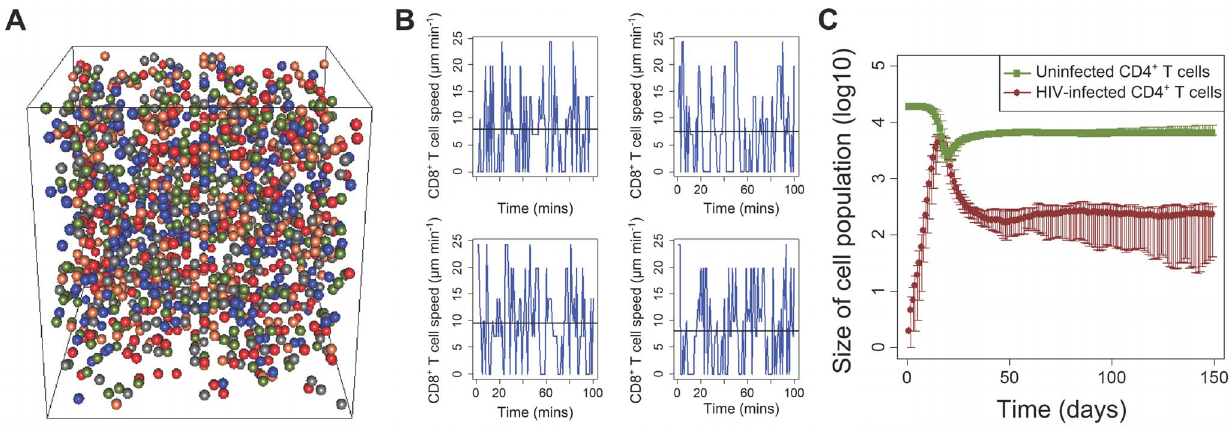
Figure 1. The cellular automaton model accurately reproduces T cell and viral dynamics at the cellular and population level. (a) A snapshot of the 3D cellular automaton model. The different coloured nodes represent the different cell populations. (b) The speed of four individual simulated CD8 + T cells in the CA model as a function of time. The mean speed is 9 m m/min and the mean motility coefficient is 75 m m 2 /min. (c) Dynamics of uninfected and infected CD4 + T cells over a course of 150 days. The bars represent the 95% central range